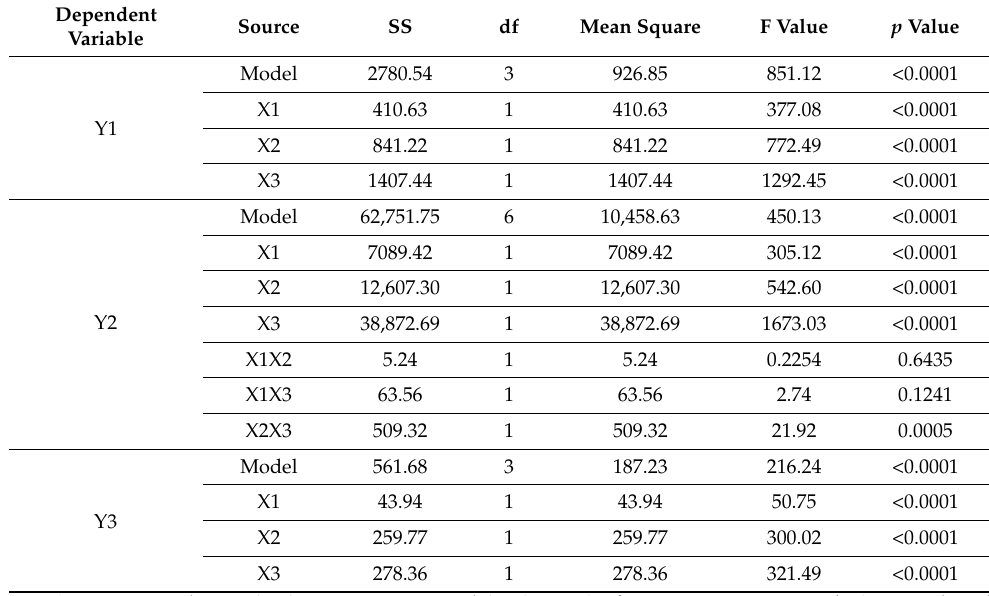
Table 4. ANOVA for I optimal design of ROS-loaded